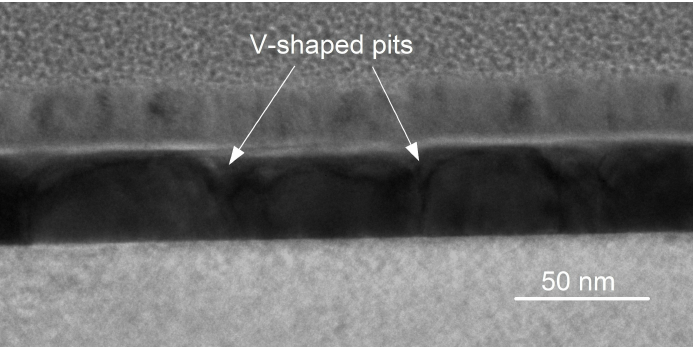
Figure 8. Bright-field TEM micrograph of sample S11. Arrows indicate locations of V-shaped pits that are formed between individual